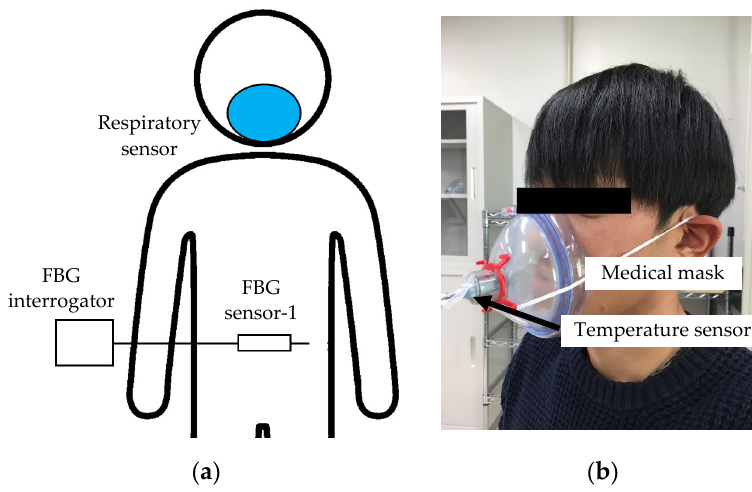
Figure 3. Schematic of verification experiment of measurement signal of FBG sensor and respiration time by respiratory sensor, and photograph of respiration sensor. ( a ) Measurement points of FBG sensor in the experiment; ( b ) Respiratory sensor with temperature sensor and medical mask.